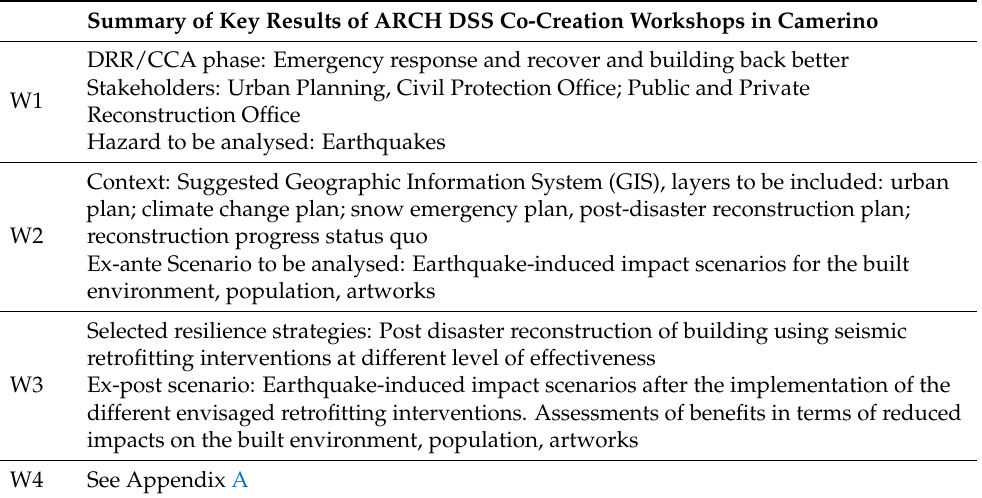
Table 3. Summary of key results after the ARCH DSS co-creation workshops W1-W4 in